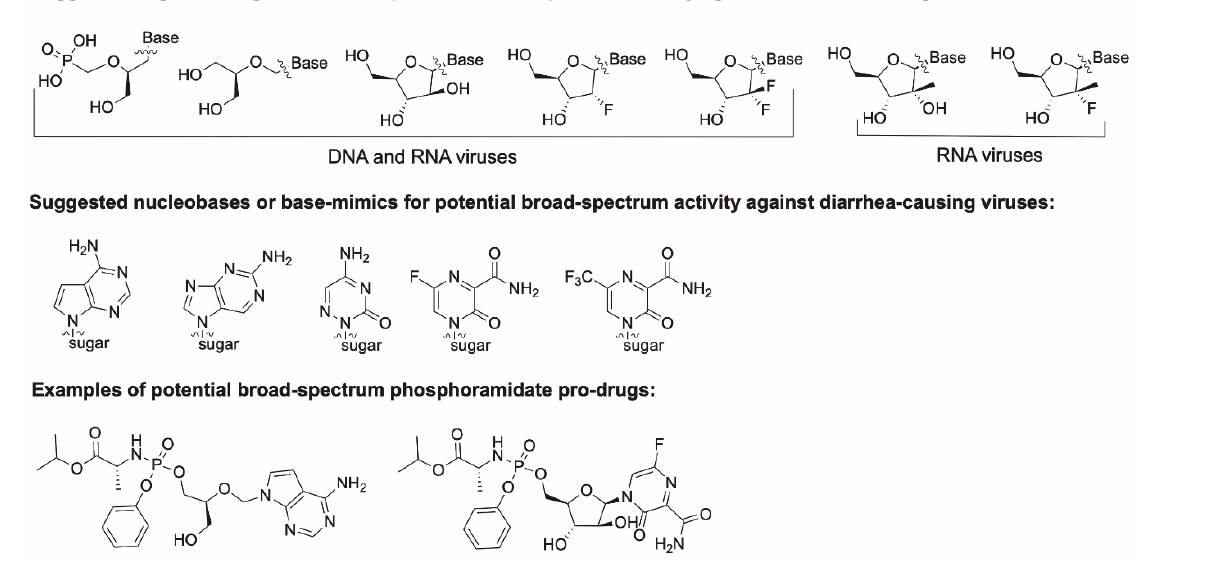
Figure 8. Potential sugar and nucleobase modifications for broad-spectrum nucleoside inhibitors. Viruses 2019 , 11 , x